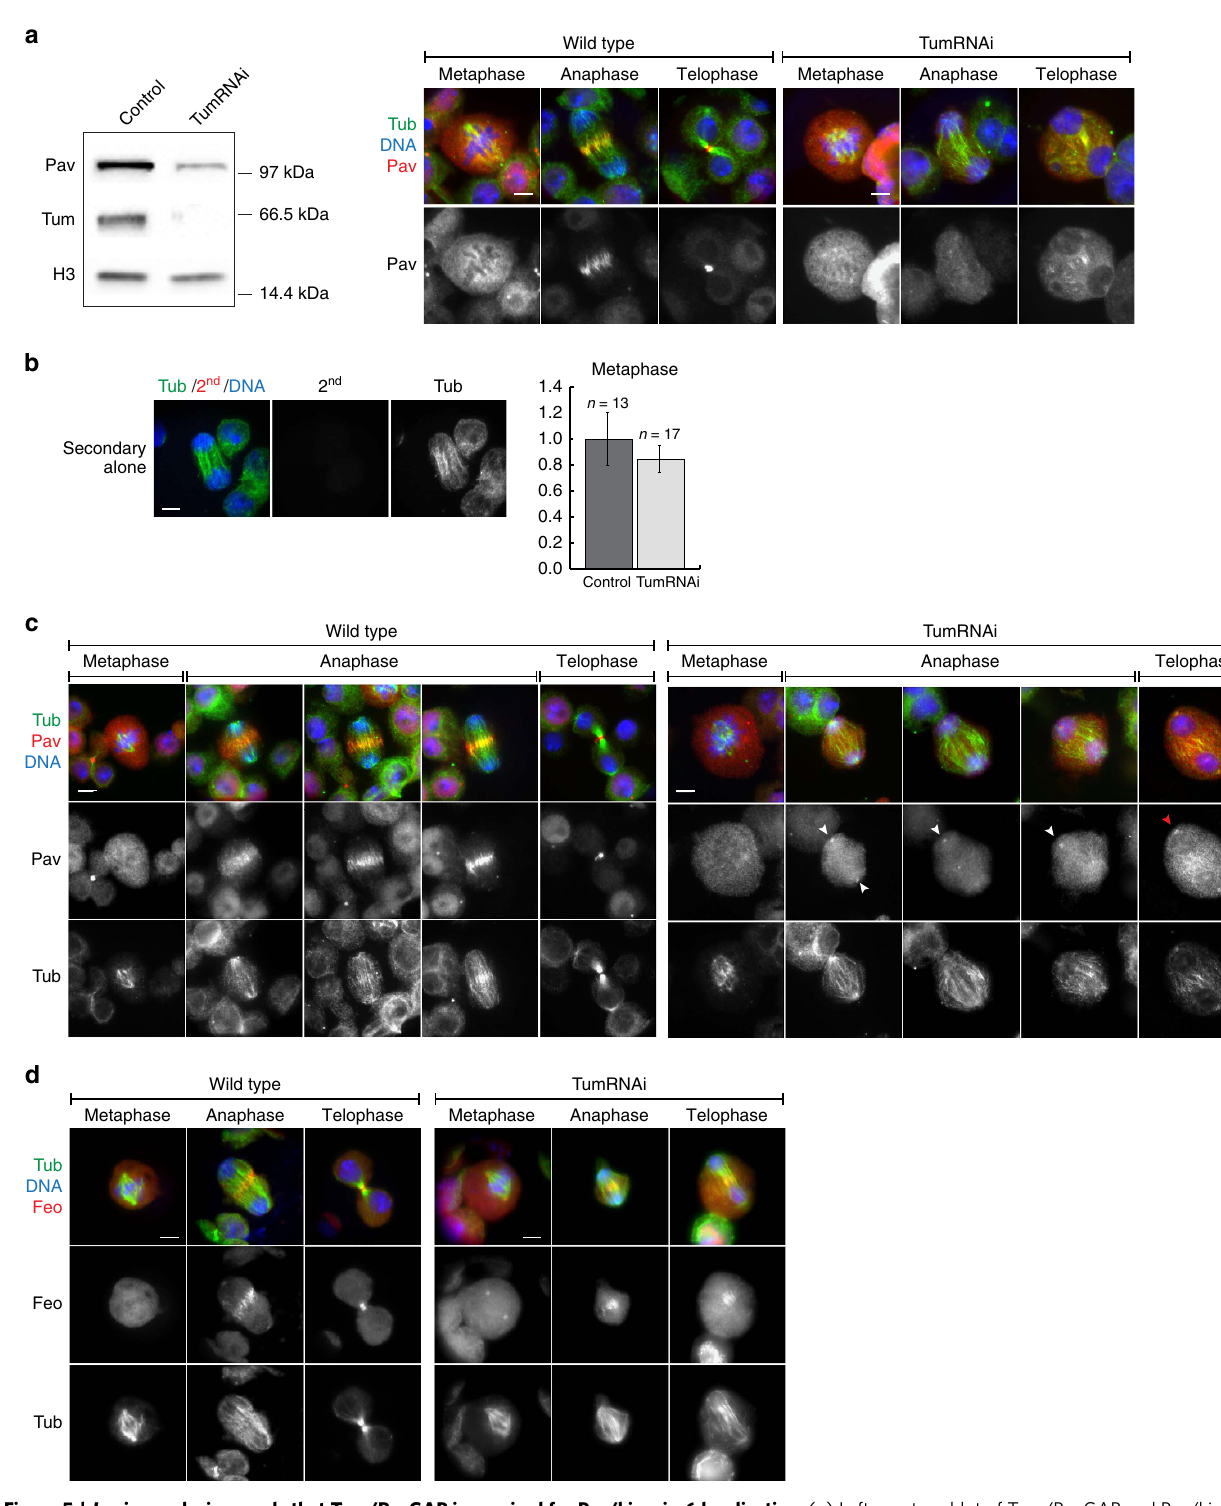
Figure 5 | In vivo analysis reveals that Tum/RacGAP is required for Pav/kinesin-6 localization. ( a ) Left: western blot of Tum/RacGAP and Pav/kinesin-6 proteins in control and in Tum/RacGAP-depleted S2 cells. H3 protein used as a control. Right: Pav/kinesin-6 levels in Tum/RacGAP-depleted and control S2 cells. Images captured with the same exposure time. Scale bar, 5 m m ( b ) Left: auto-fluorescence test of secondary antibody used against Pav/kinesin-6. S2 cells stained with DAPI (blue), Tubulin (green) and secondary antibody (red) without anti-Pav/kinesin-6 primary antibody. Right: average fluorescence intensity of Pav/kinesin-6 normalized to the control in Tum/RacGAP-depleted cells during metaphase. ( c ) Metaphase, anaphase and telophase in control (left panel) and Tum/RacGAP-depleted (right panel) S2 cells. White arrowheads: localization of Pav/kinesin-6 at centrosomes of early-late anaphases. Red arrowheads: Pav/kinesin-6 localization on telophase centrosomes. Cells stained for tubulin (green), DNA (blue) and Pav/kinesin-6 (red). Scale bar, 5 m m. ( d ) Feo/PRC localization during metaphase, anaphase and telophase in control (left panel) and Tum/RacGAP-depleted (right panel) S2 cells. Cells stained for tubulin (green), DNA (blue) and Feo/PRC (red). Scale bar, 5 m m. NATURE COMMUNICATIONS|7:11182|DOI: